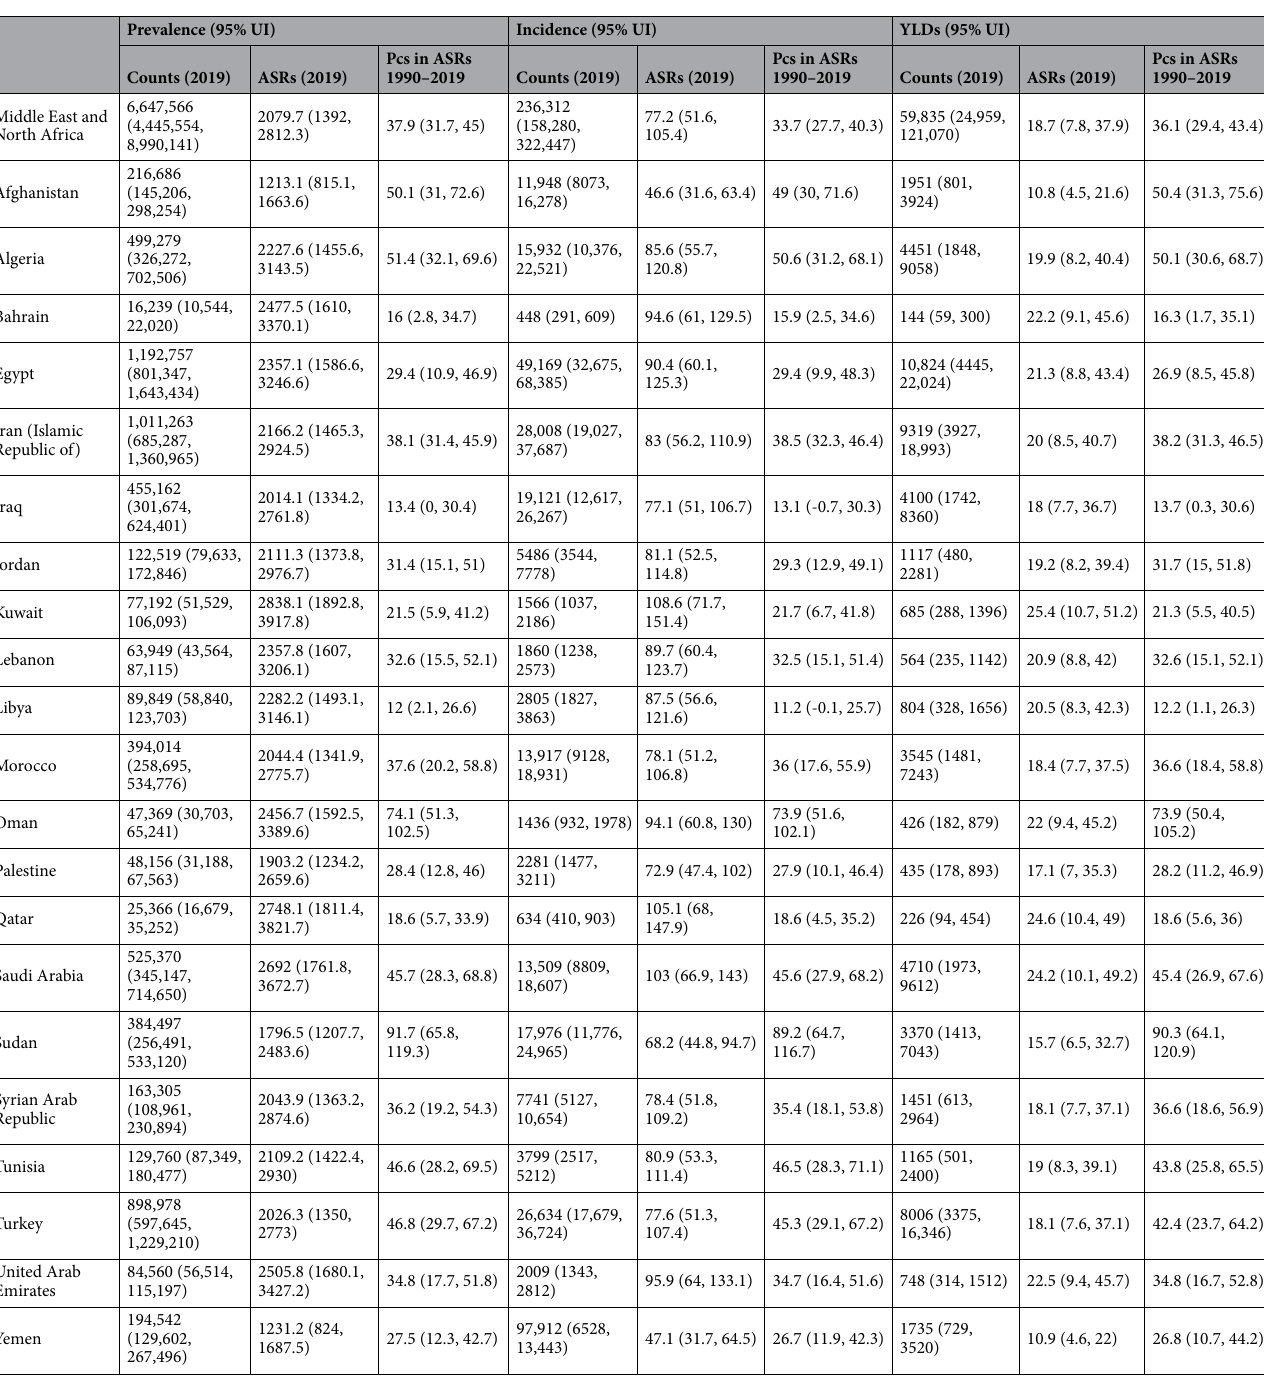
Table 1. Prevalent cases, incident cases and years lived with disability (YLDs) due to polycystic ovary syndrome in the Middle East and North Africa region in 2019 and the percentage change in the age- standardised rates (ASRs) per 100,000 women from 1990 to 2019 (Generated from data available from http:// ghdx. healt hdata. org/ gbd- resul ts-